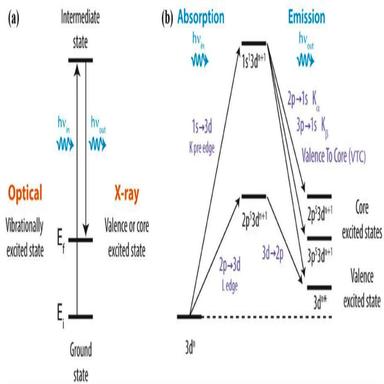
Representations of RIXS process. (a) RIXS as the X-ray analog of resonance Raman scattering. (b) Schematic of the RIXS processes for 3d transition-metal systems at hard (K-edge) and soft (L-edge) X-ray absorption edges .